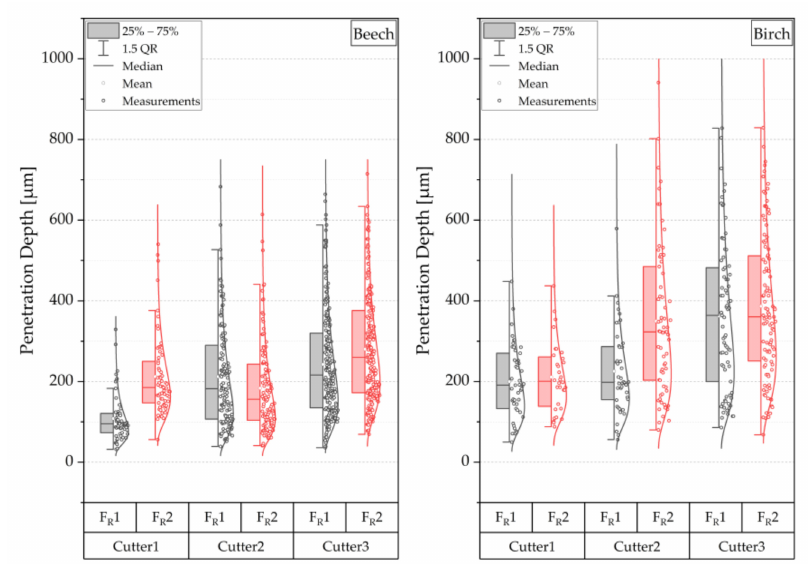
Figure 12. Effects on penetration depth and visualization of the distribution of vessels filled with adhesive; Cu1 blunt, Cu2 medium sharp, and Cu3 sharp; F R 1 4 m min − 1 and F R 2 25 m min − 1